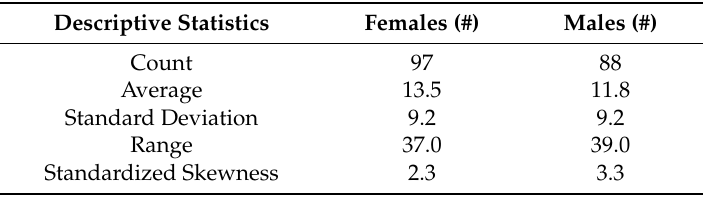
Table 3. Statistical summary of BDI-II scores by gender.